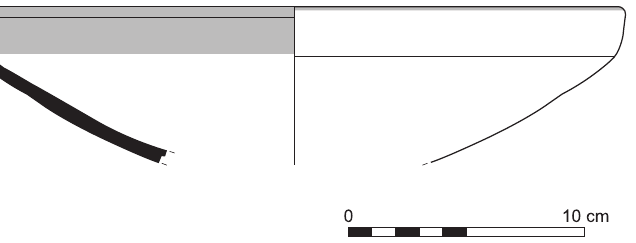
Fig 24. Platter bowl S/8267/4429 painted with a horizontal red painted band on the inner surface under the